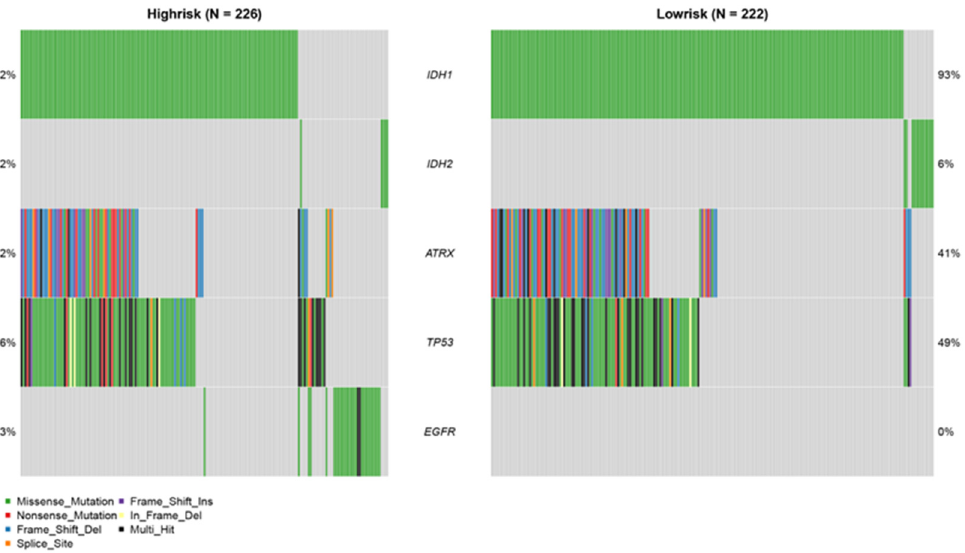
Figure 8 . Mutation analysis in the TCGA cohort . Figure 8. Mutation analysis in the TCGA